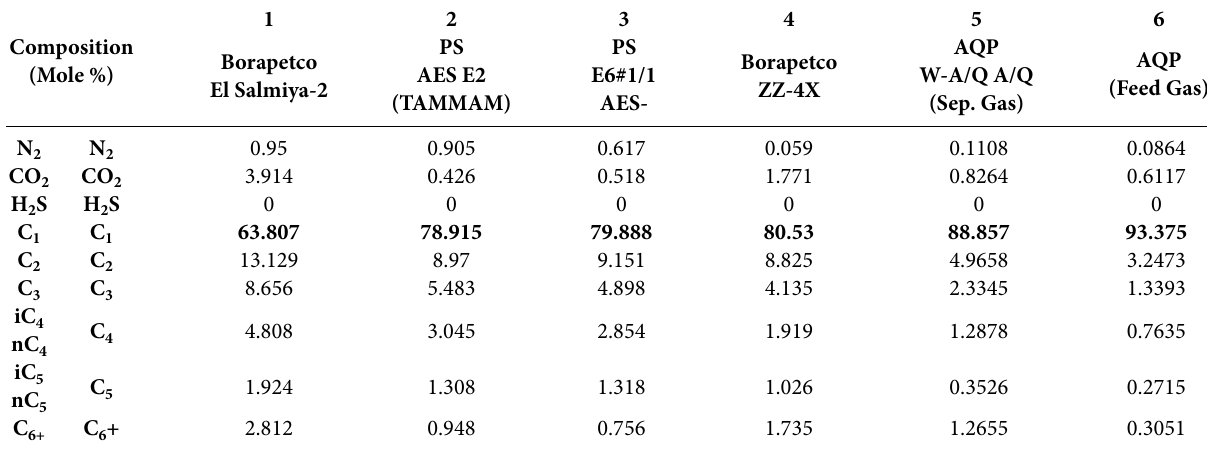
Table 1. Typical feed selected to